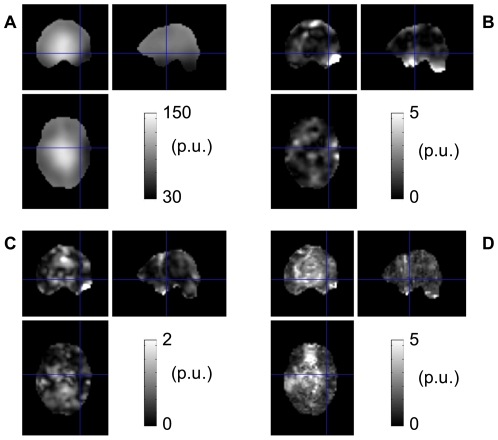
Precision and linearity of the 3D EPI method.Typical B1
+ (a), non-linearity (b) instability (c) and SDB1+ (d) maps obtained with the optimal configuration using a maximum RF nominal value of 310° and off-resonance minimization.